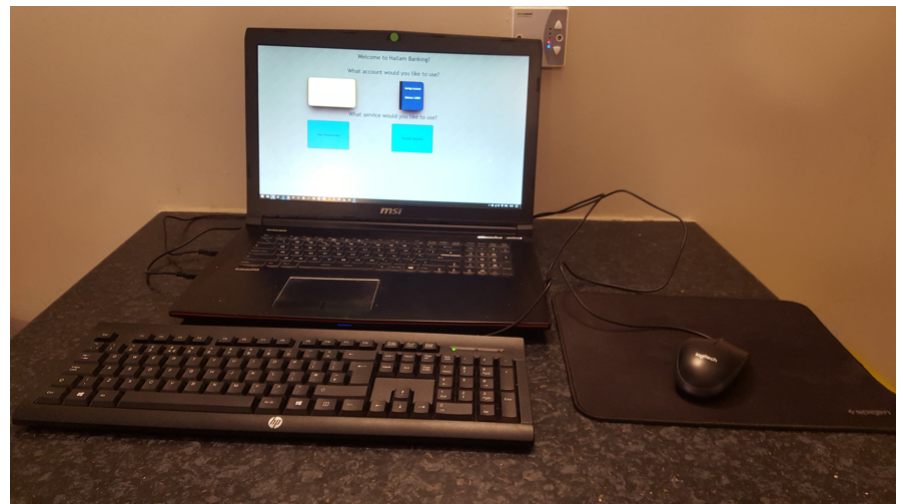
Figure 9. Our experimental setup.